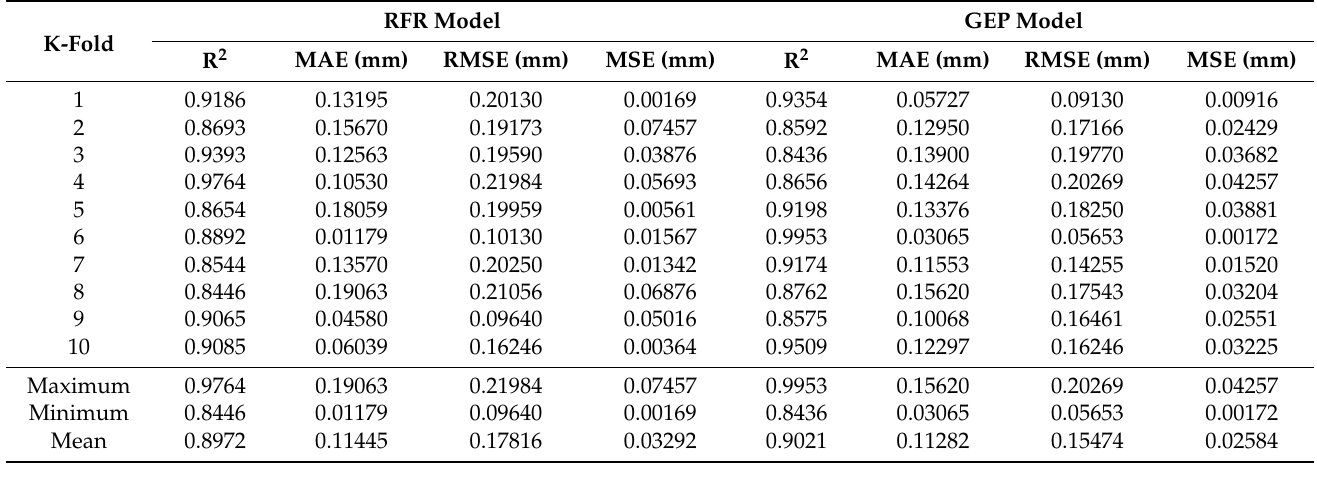
Table 6. Summary of statistical metrics considered in K-Fold cross validation.